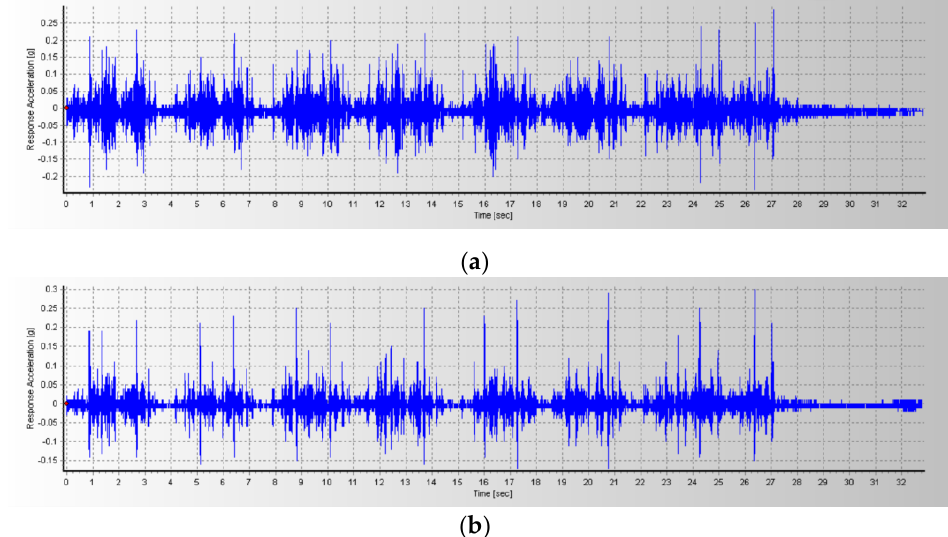
Figure 9. Ground vertical acceleration time . ( a ) Ground vertical acceleration time range curve at